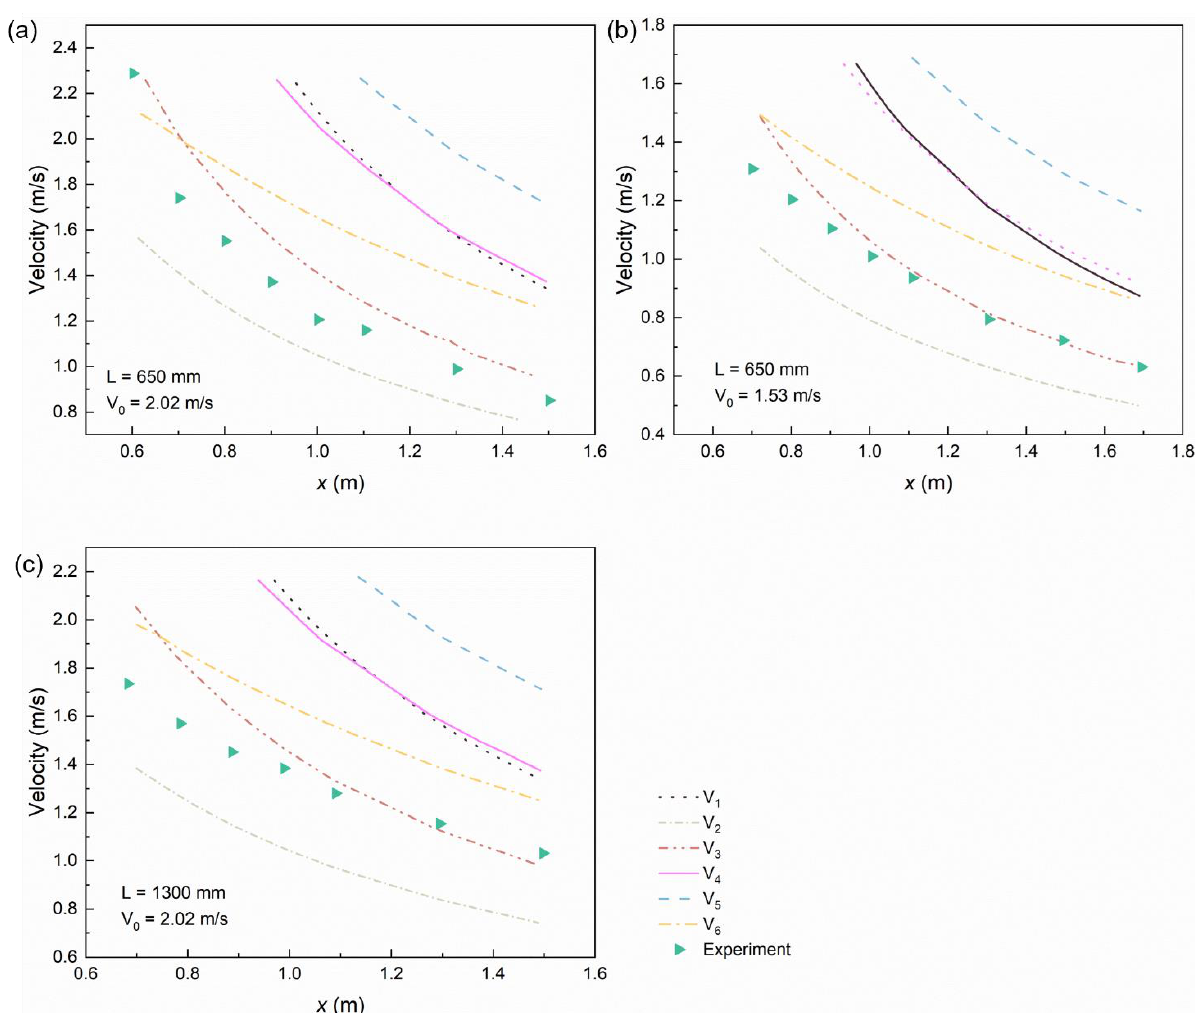
Figure 8. Comparison of theoretical models and actual measurements of axial velocity attenuation of the main part of multiple parallel jets: ( a ) L = 650 mm, V 0 = 2.02 m/s; ( b ) L = 650 mm, V 0 = 1.53 m/s; ( c ) L = 1300 mm, V 0 = 2.02 m/s.